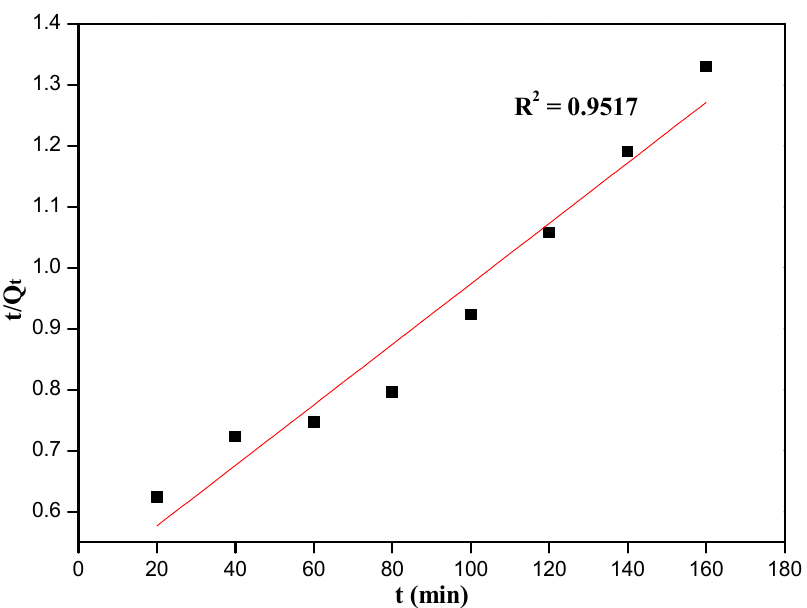
Figure 10. Fit of kinetic data to pseudo-second-order model.